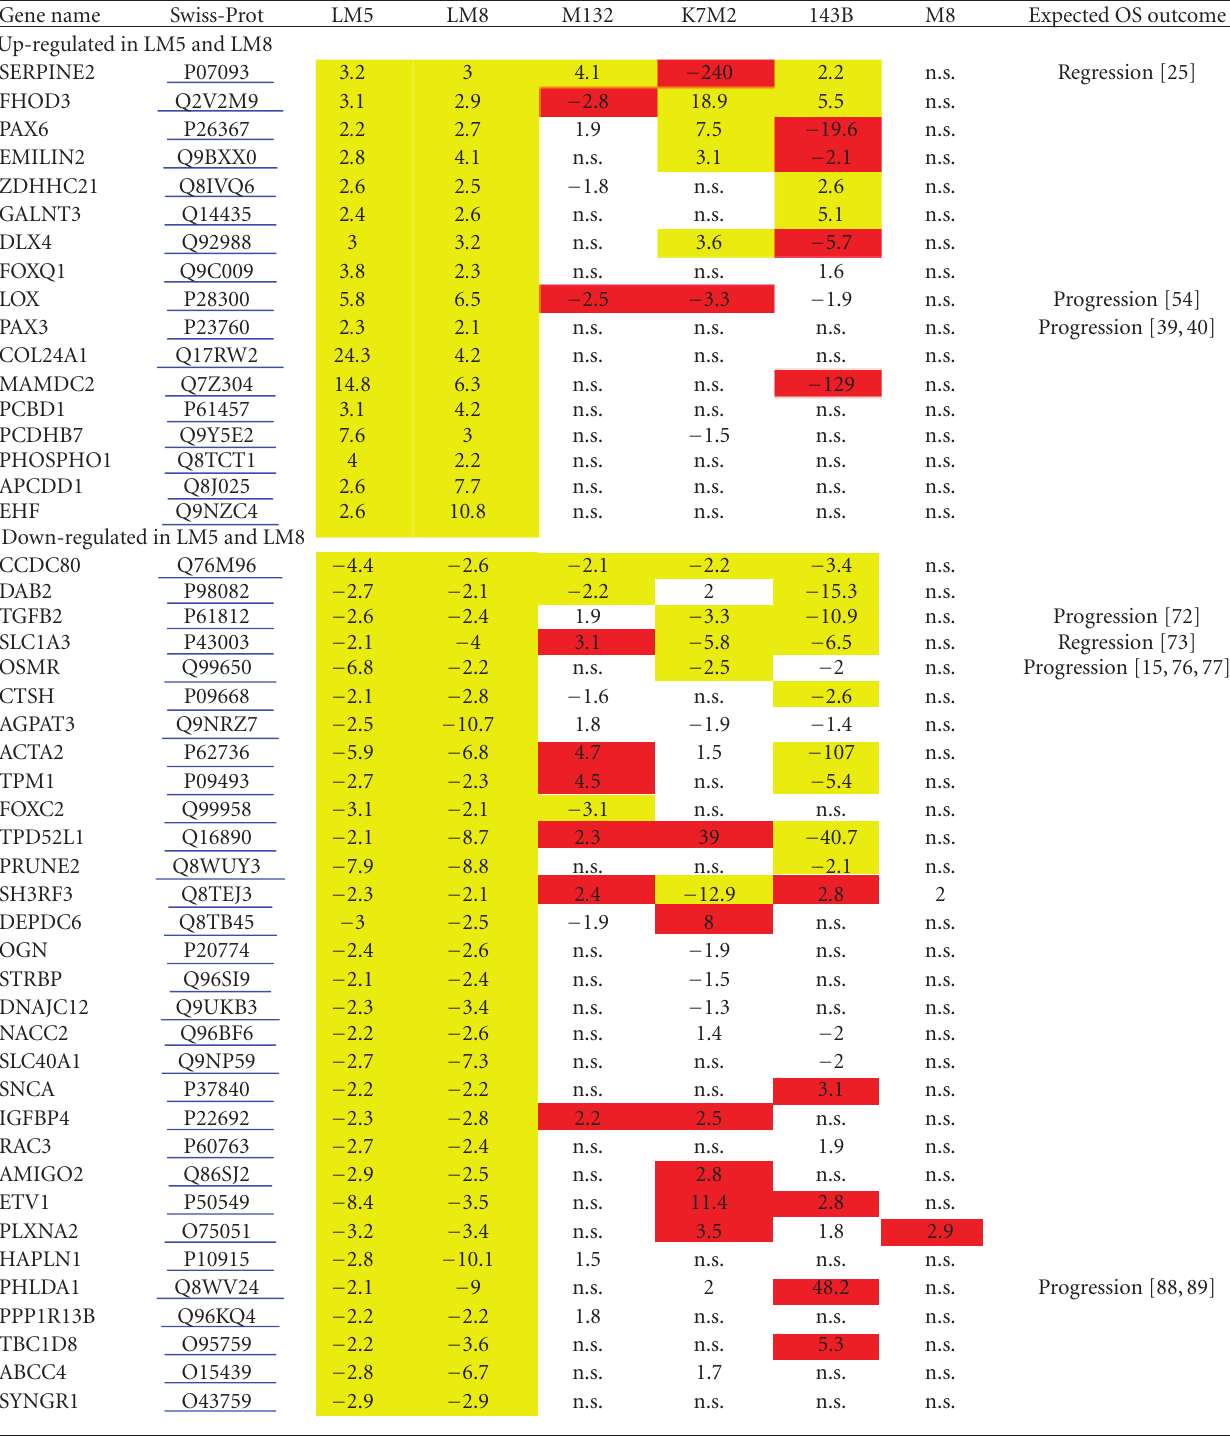
Table 4: Commonly up- and downregulated genes in